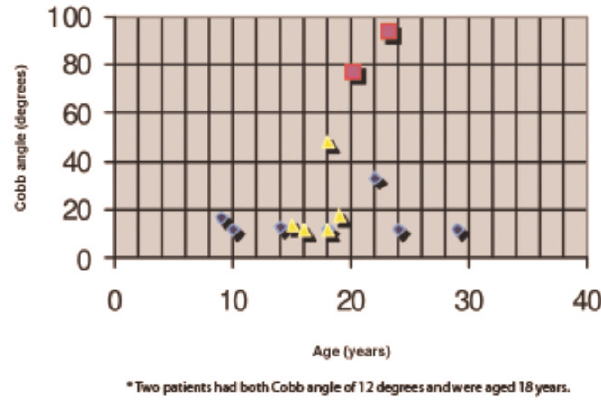
Figure 1 - Pattern of the scoliosis curves in 14 Williams-Beuren syndrome patients according to age: blue points indicate single curves, yellow triangles indicate double curves and pink squares indicate triple curves*.